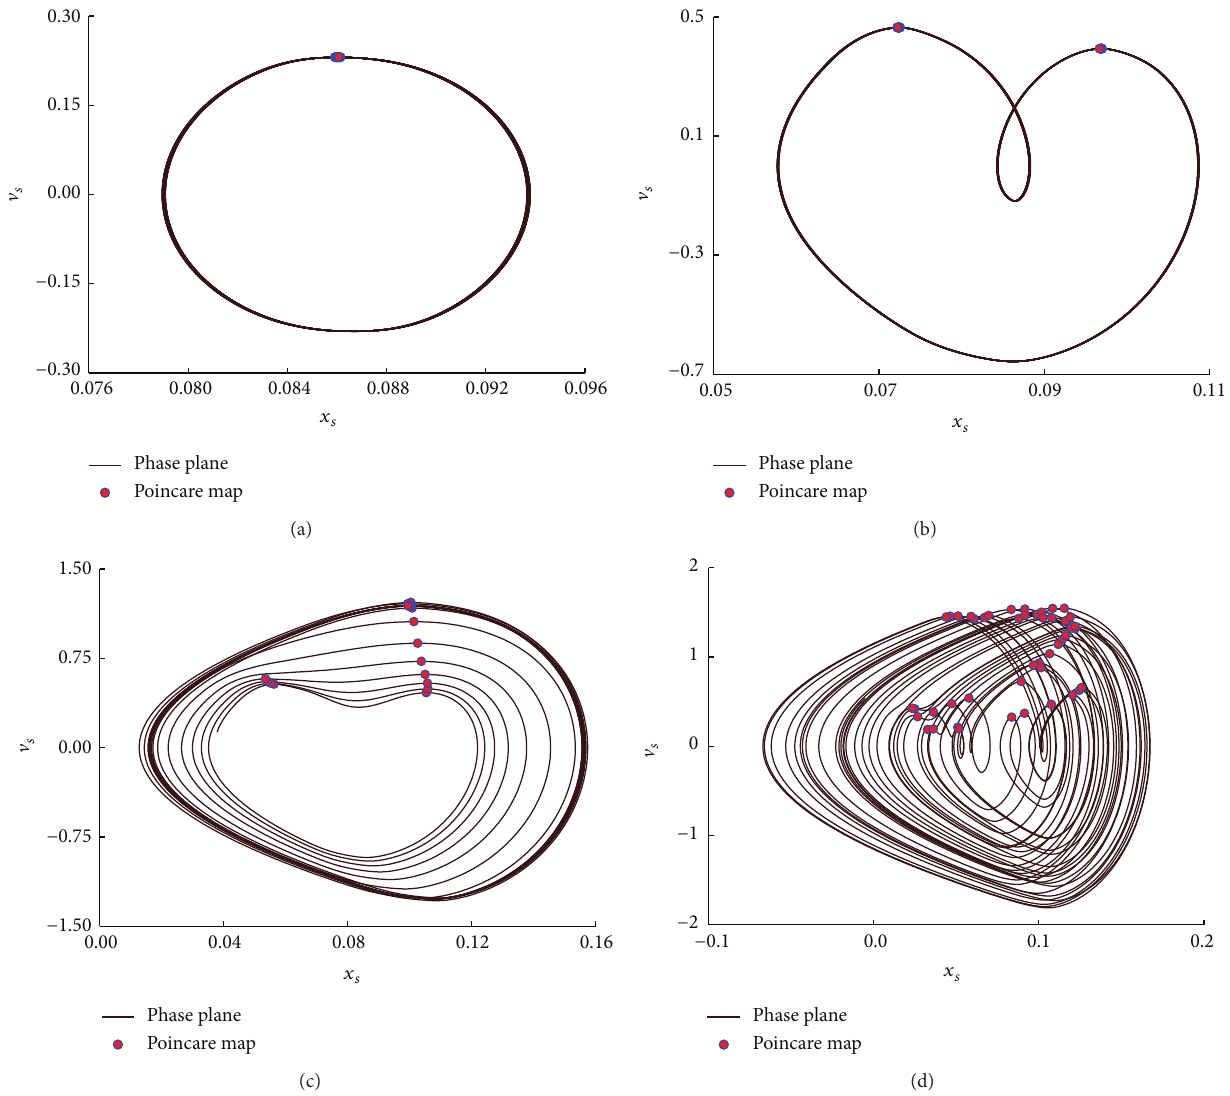
Figure 9: Phase plane portraits and corresponding Poincare maps (velocity V 𝑠 versus displacement 𝑥 𝑠 ) for different 𝐴 𝑚 : (a) 𝐴 𝑚 = 0 .01 m; (b) = 0 .02316 m; (c) 𝐴 = 0 .02720 m; (d) 𝐴 = 0 .06 𝐴 𝑚 𝑚 𝑚